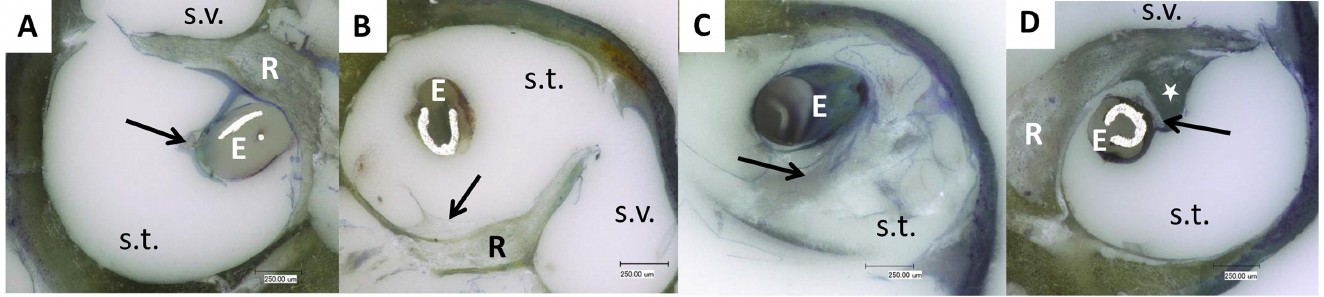
Fig 10. Representative images of grinded cochleae. The tissue reaction in 10% DEX (A), 1% DEX (B), 0% DEX + ES (C) and 0% DEX without ES (D) treated guinea pig cochleae is representatively shown. E: electrode; s.t.: scala tympani; s.v.: scala vestibuli; arrow: fibrosis; star: ossification; R: Rosenthal ‘ s canal; Magnification: